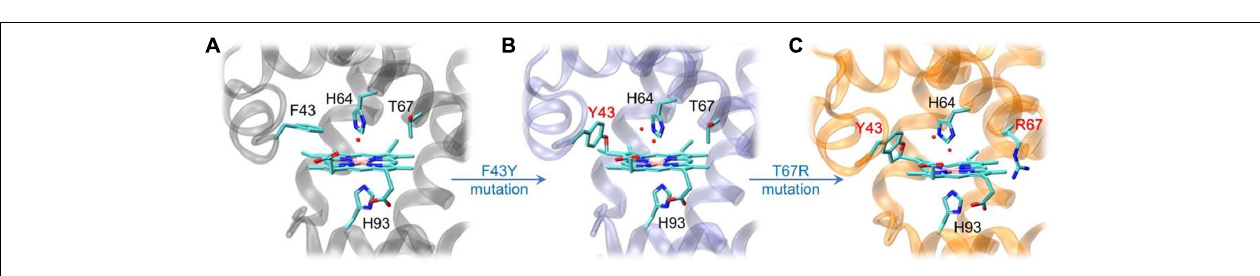
FIGURE 1 | (A) Representative chemical structure of lignin. (B) Three major monomers of lignin: p -coumaryl alcohol, coniferyl alcohol and sinapyl alcohol unit, respectively.